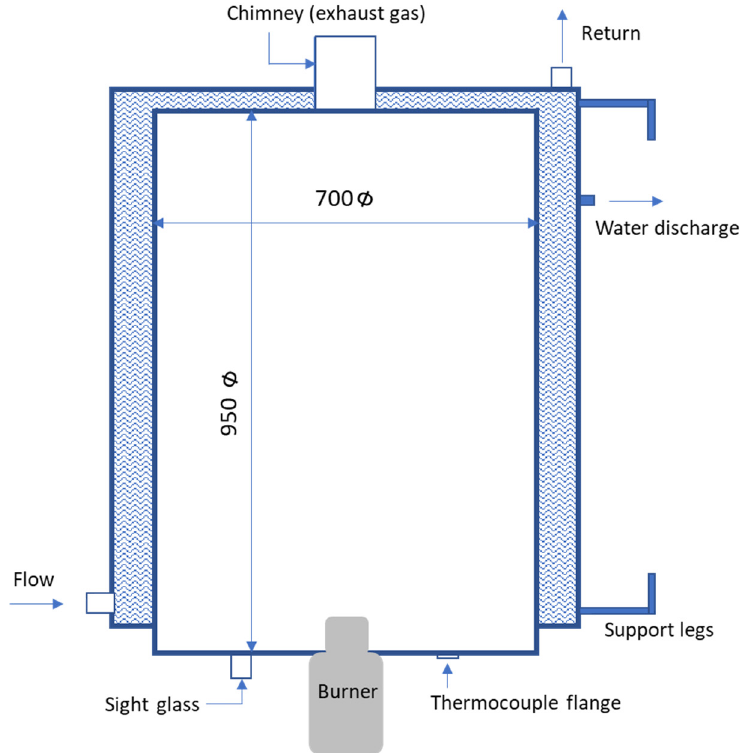
Figure 1. Combustion chamber outline and dimensions (mm).